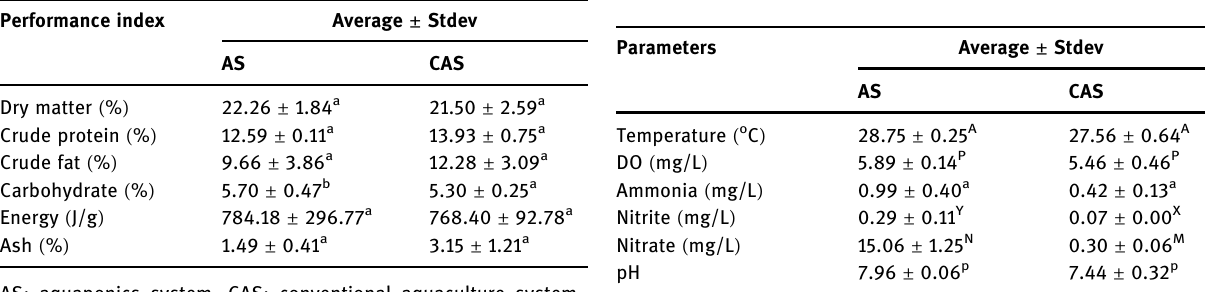
Table 4: Physicochemical water quality parameters ( temperature, DO, ammonia, nitrite, nitrate, and pH ) measured in the rearing water of aquaponic system and conventional aquaculture